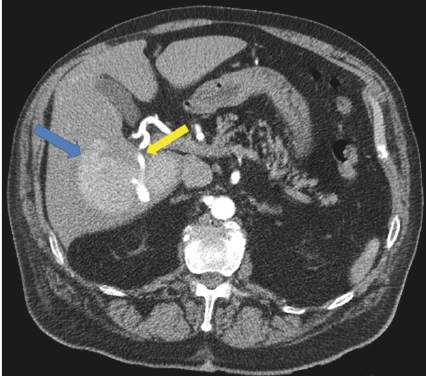
Figure 2: Axial plane CT angiography of the abdomen early arterial phase demonstrates contrast filling of an intrahepatic pseudoa- neurysm (blue arrow) by a prominent right hepatic artery (yellow arrow).